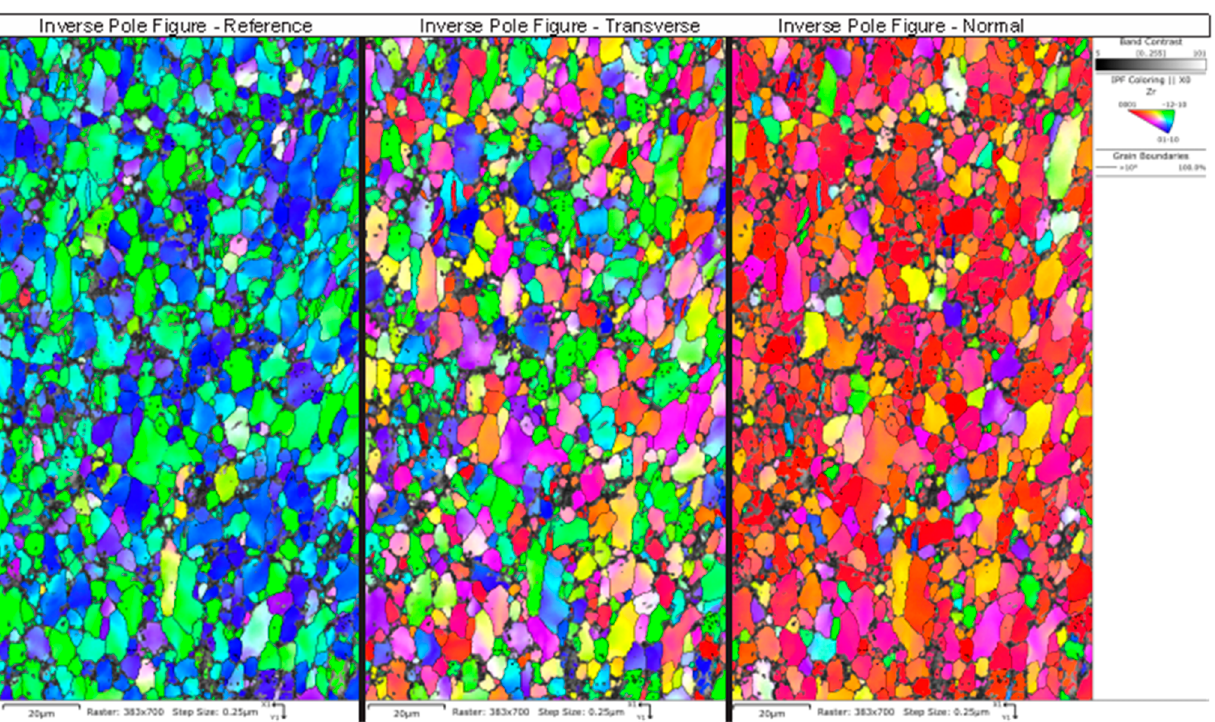
Figure 14. Pole figures are shown for the four NPG tubes: ( a ) Tube a-1-05, ( b ) Tube a-2-05, ( c ) Tube d-7-05 and ( d ) Tube d-8-05. As the Kearn values indicated, there are no discernible differences between the as-plated getter tubes and those given pretreatment and activation.